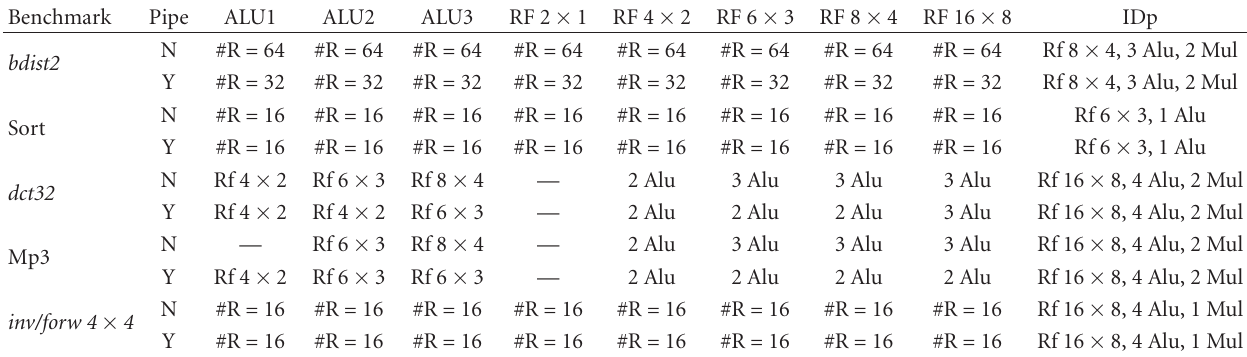
Table 5: Di ff erence in components and parameters between respective baseline and generated design.